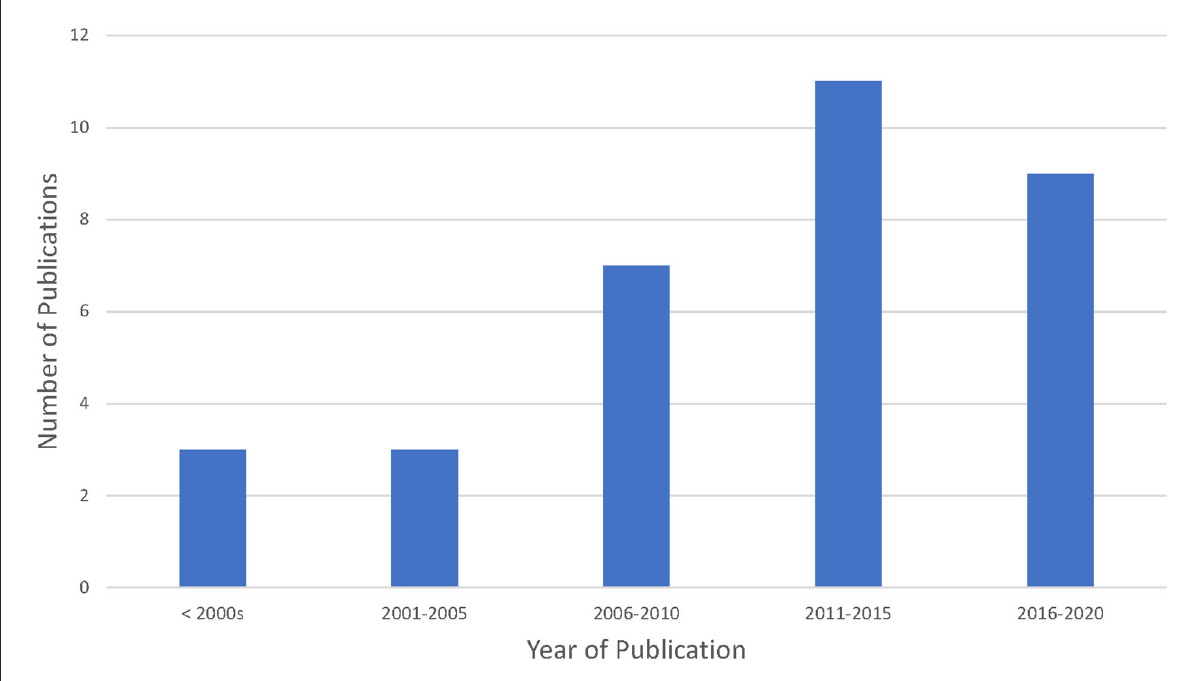
FIGURE2 Year of publication for included articles.